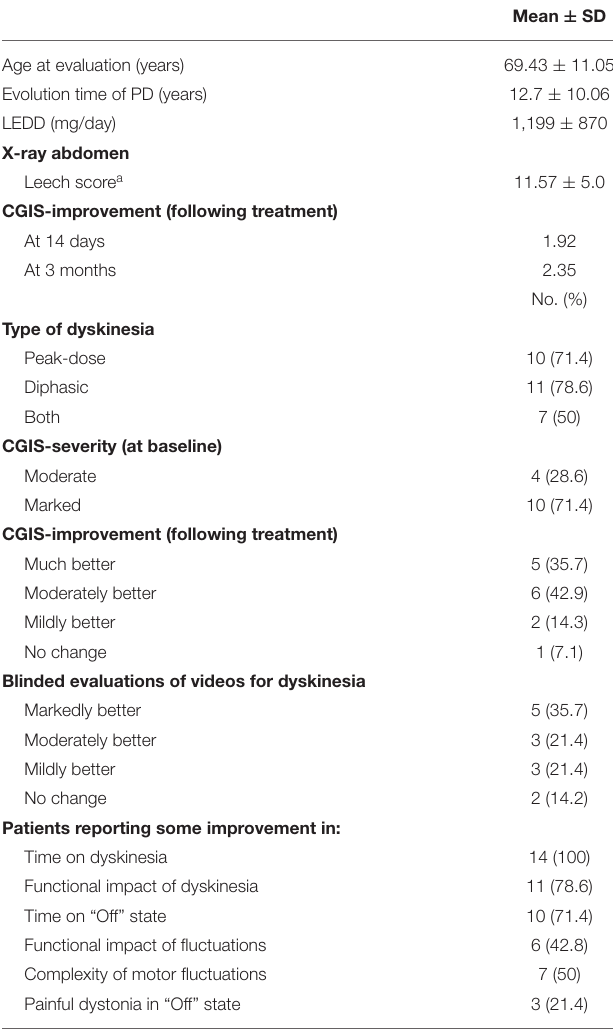
TABLE 1 | Summary of clinical features of included